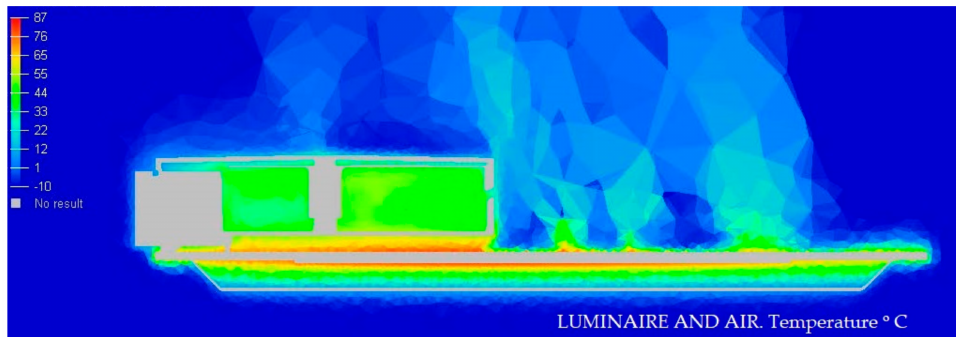
Figure 12. Temperature medium section of the luminaire at − 10 ◦ C. Source: HyperView software.